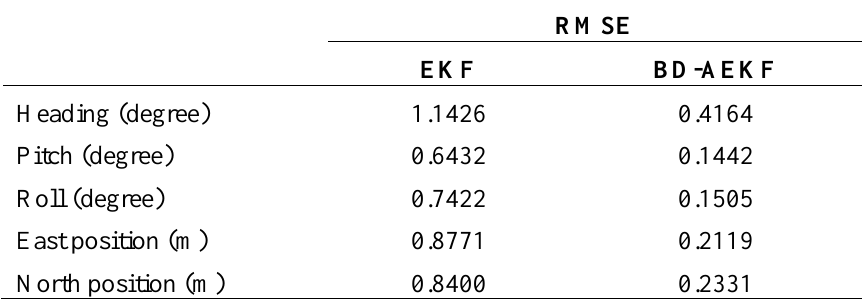
Table 1. Comparison of errors between EKF and BD-AEKF ( 30sin t 